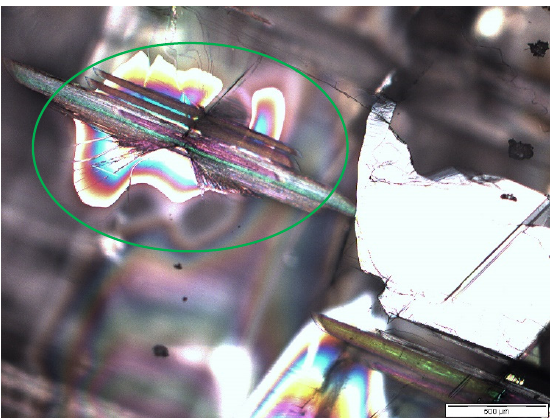
Figure 4. Gypsum crystal, reaction stopped after beginning of dehydration,